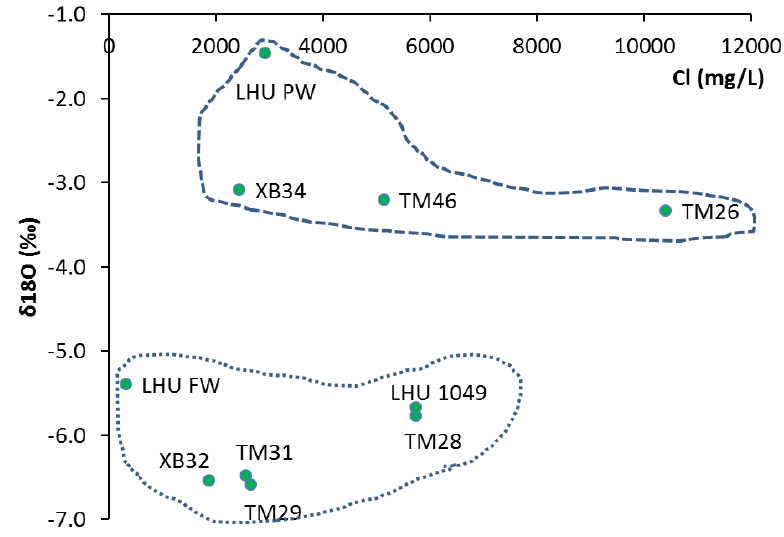
Figure 8. The chloride and δ 18 O distribution.